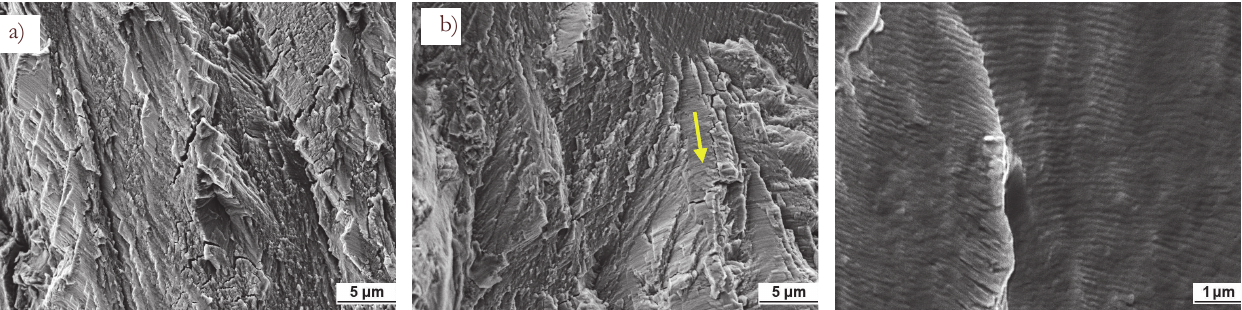
Figure 10: Fracture surface corresponding to the average crack rate 1 x 10 -5 mm/cycle. Figure 11: Fracture surface corresponding